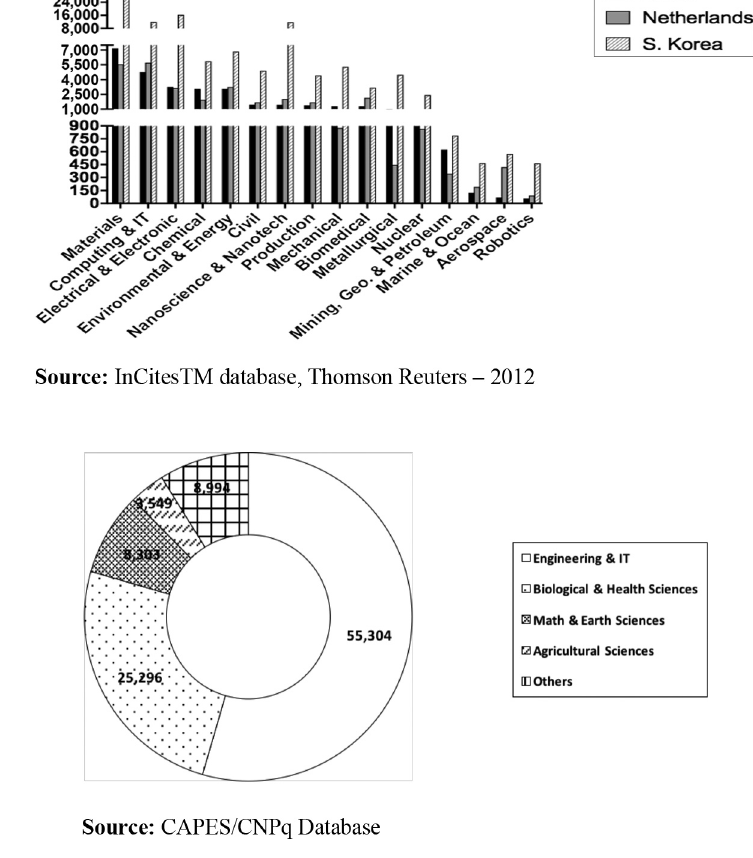
Figure 6. Comparison of